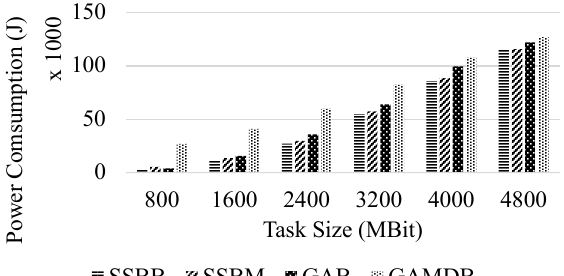
Figure 4. Total power consumption of the